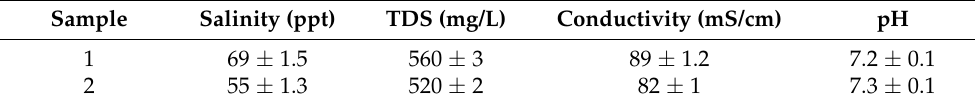
Table 1. Characterization of water samples collected from the Arabian Sea, Mumbai.